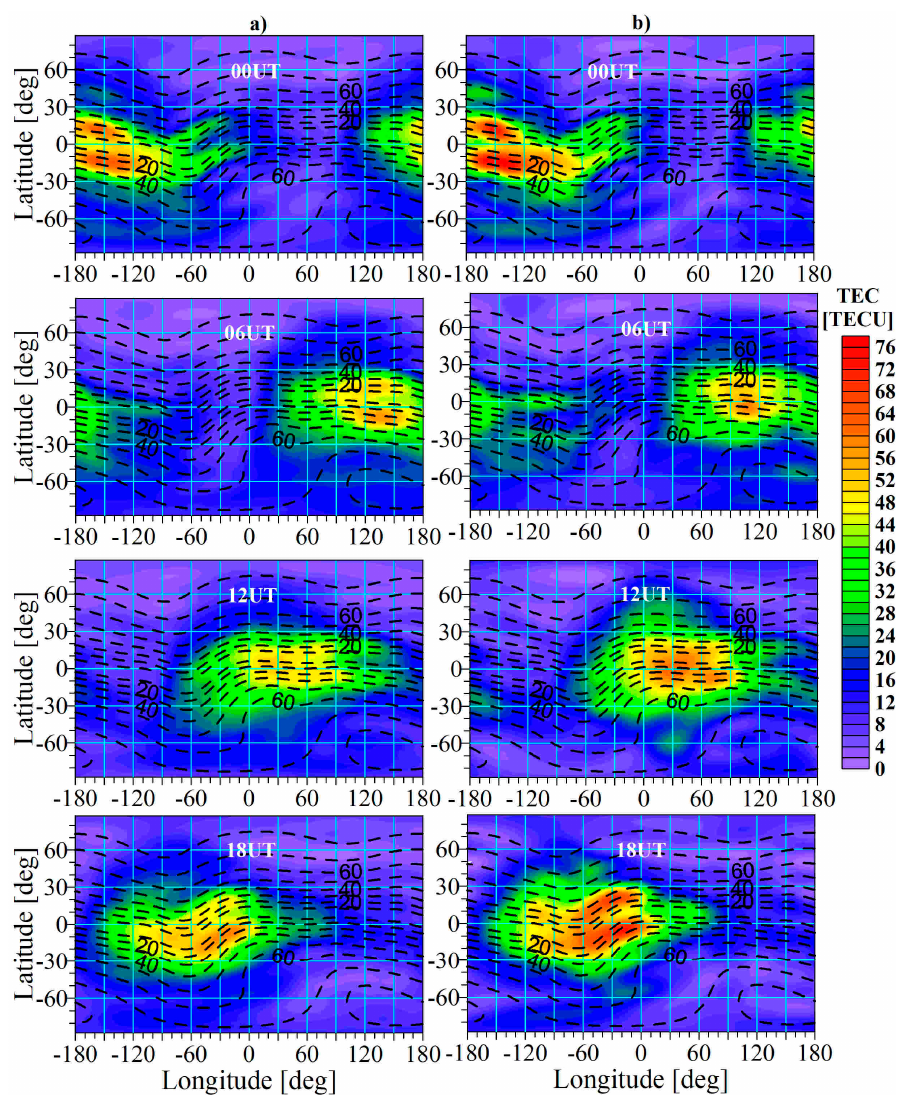
Figure 11. ( a ) Latitudinal and longitudinal distribution of median TEC and ( b ) measured TEC on 4 February 2022. Lines of equal inclination of the Earth’s magnetic field are shown with a black dashed line.